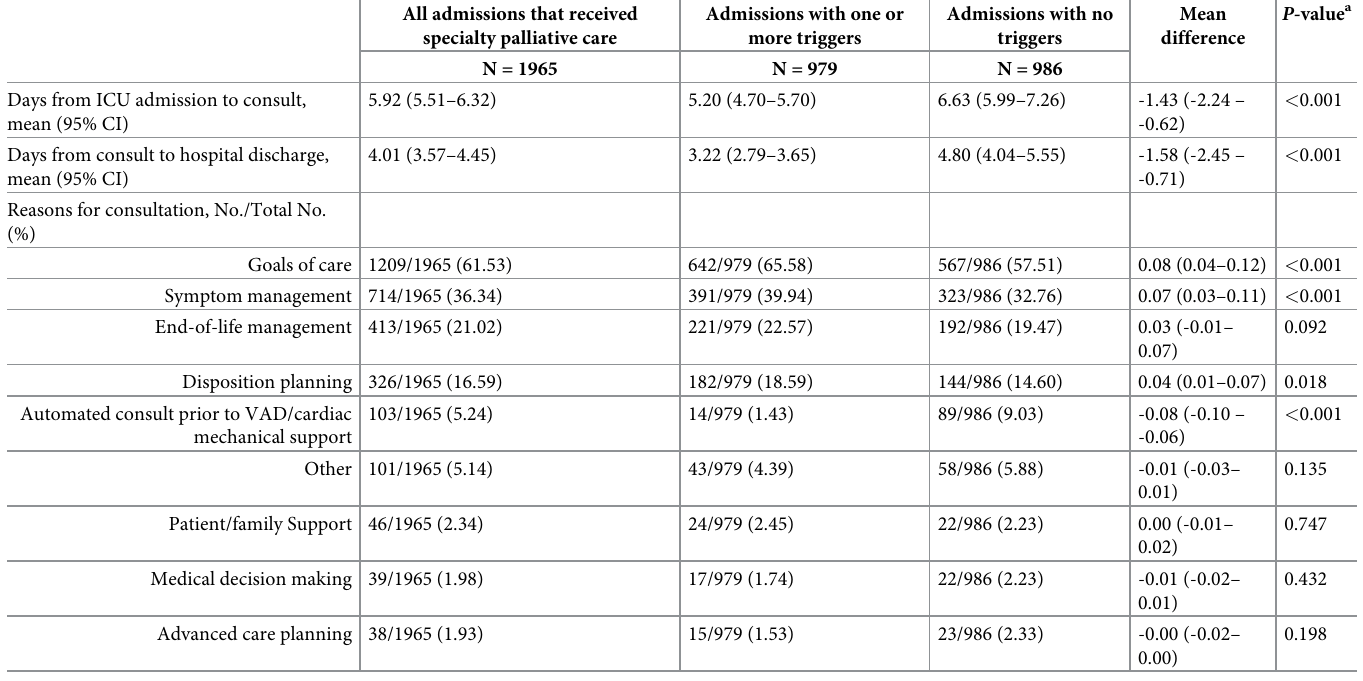
Table 2. Characteristics of specialty palliative care consultations in the intensive care unit.